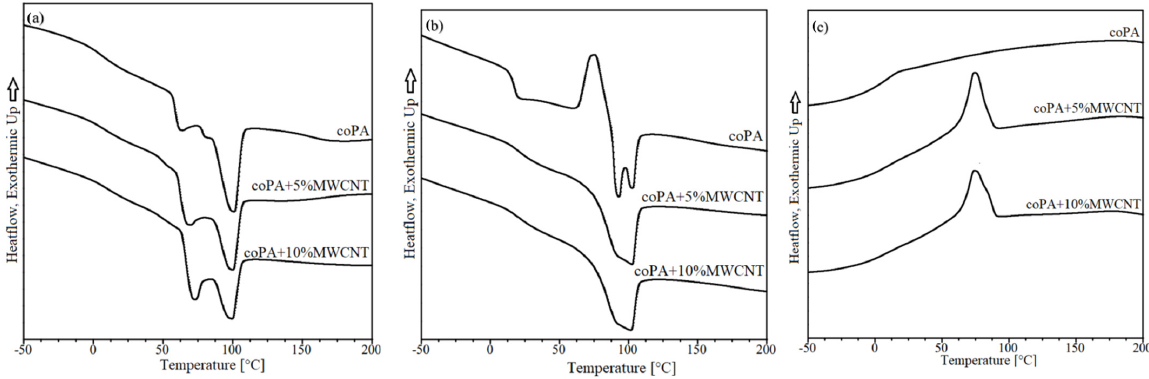
Figure 6. ( a ) First heating curves; ( b ) second heating curves; and ( c ) cooling curves for the unfilled coPA and masterbatches containing 5 wt% and 10 wt%